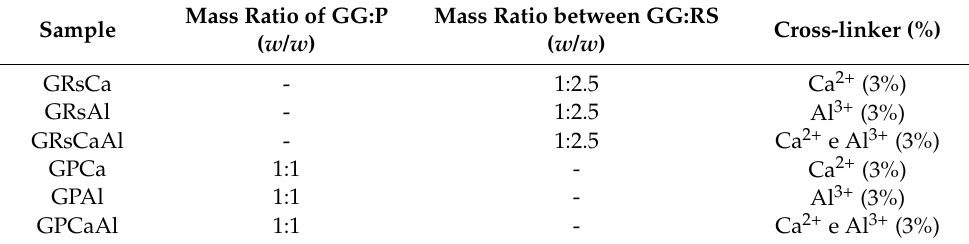
Table 1. Microparticle nomenclature and composition.